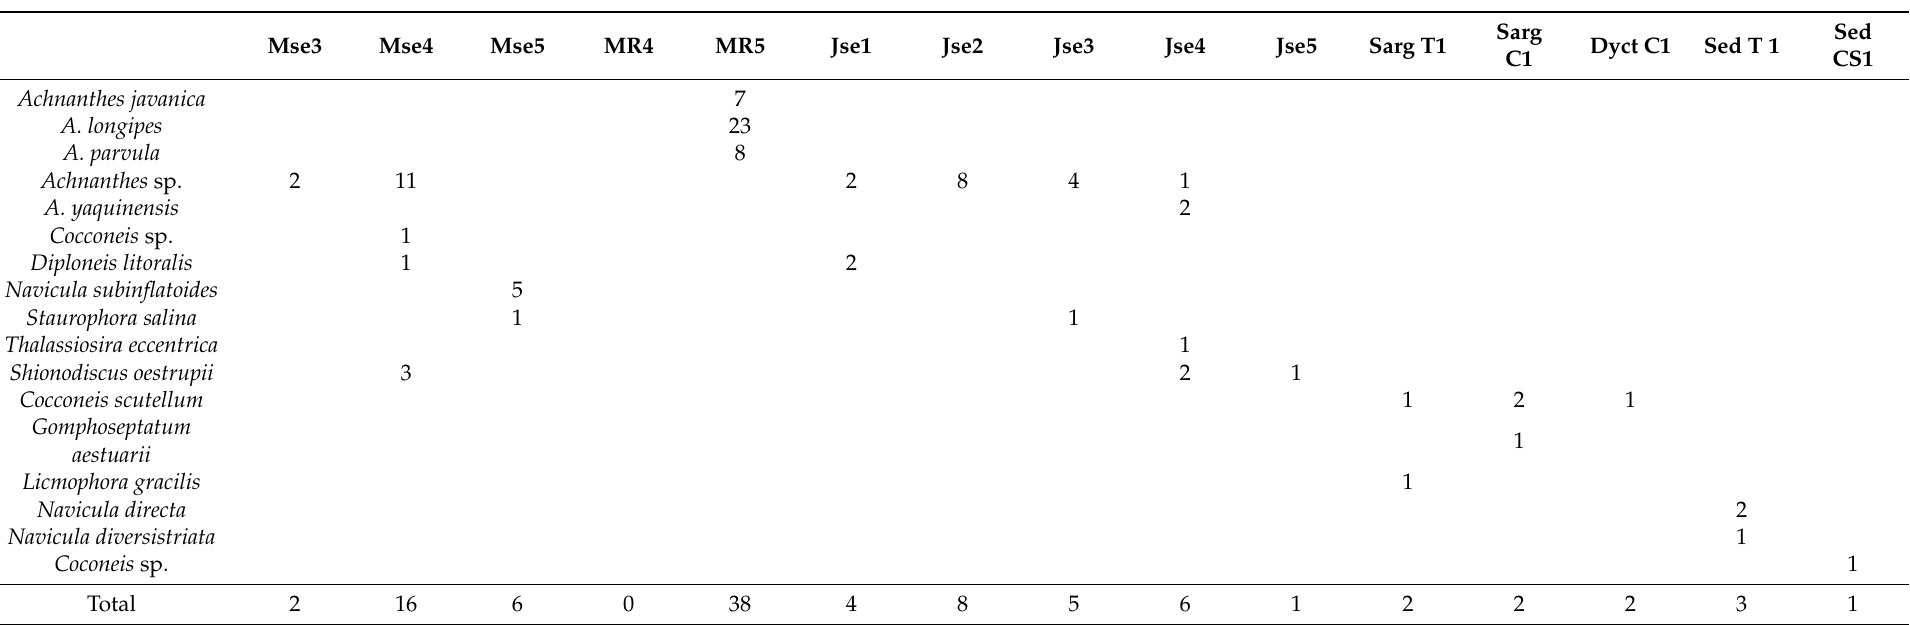
Table 7. Deformed valves from the sampling stations at Port and Costa of Santa Rosalia, and Control Site (CS). M = may, J = January, Se = sediment, R = rock, T = tanques, C =